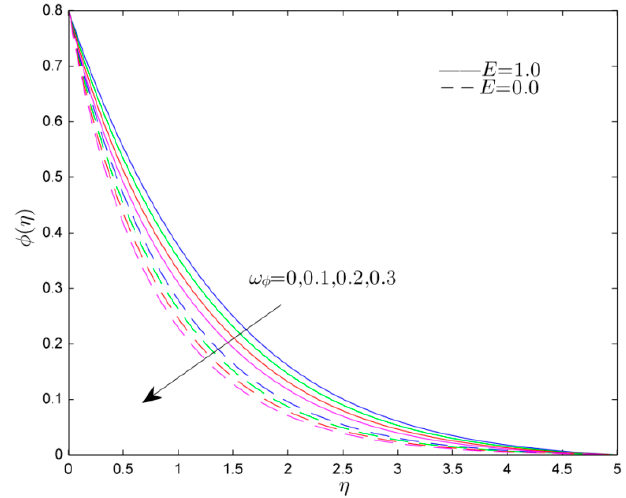
Figure 15. Effect of Mass relaxation parameter (𝜔 (cid:3109) ) on 𝜙(𝜂) .